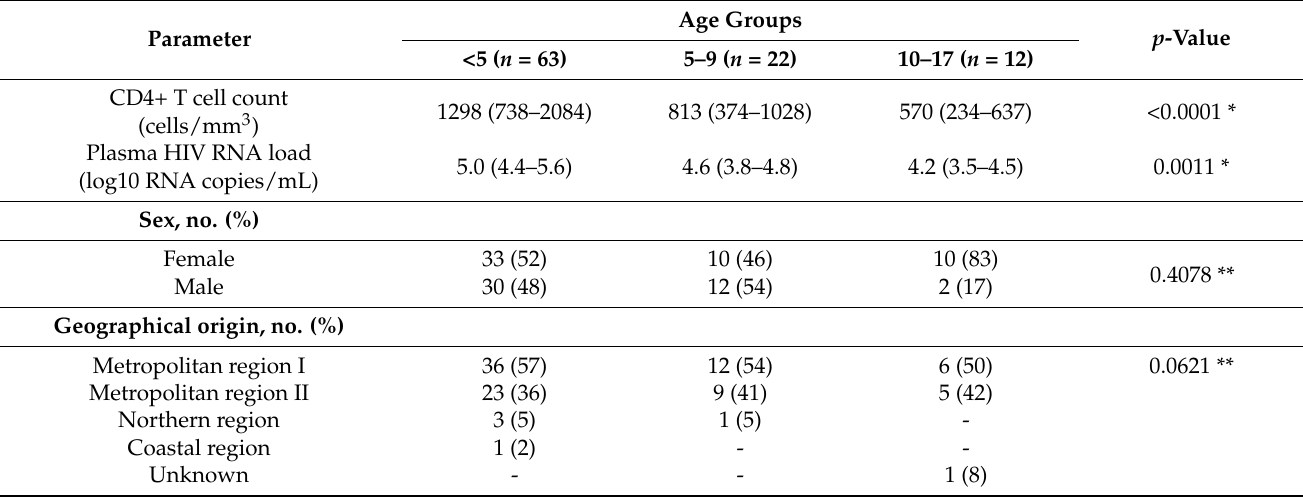
Table 1. Virological, demographic, and laboratory data of HIV-infected children analyzed between 2008 and